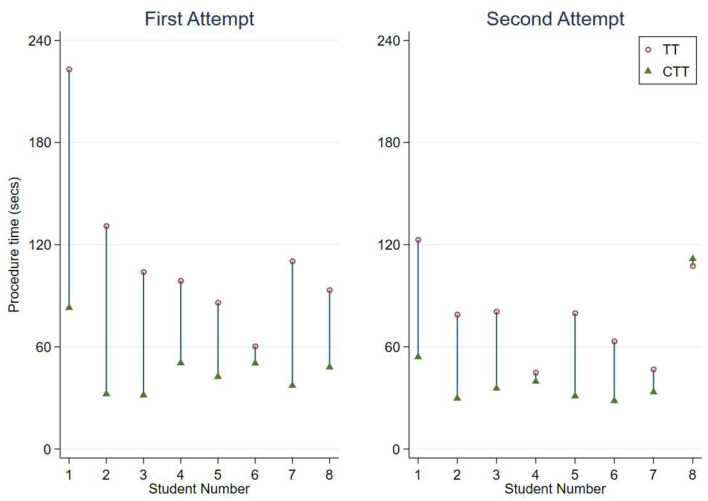
Pairs plot showing procedure times for each student, by attempt.